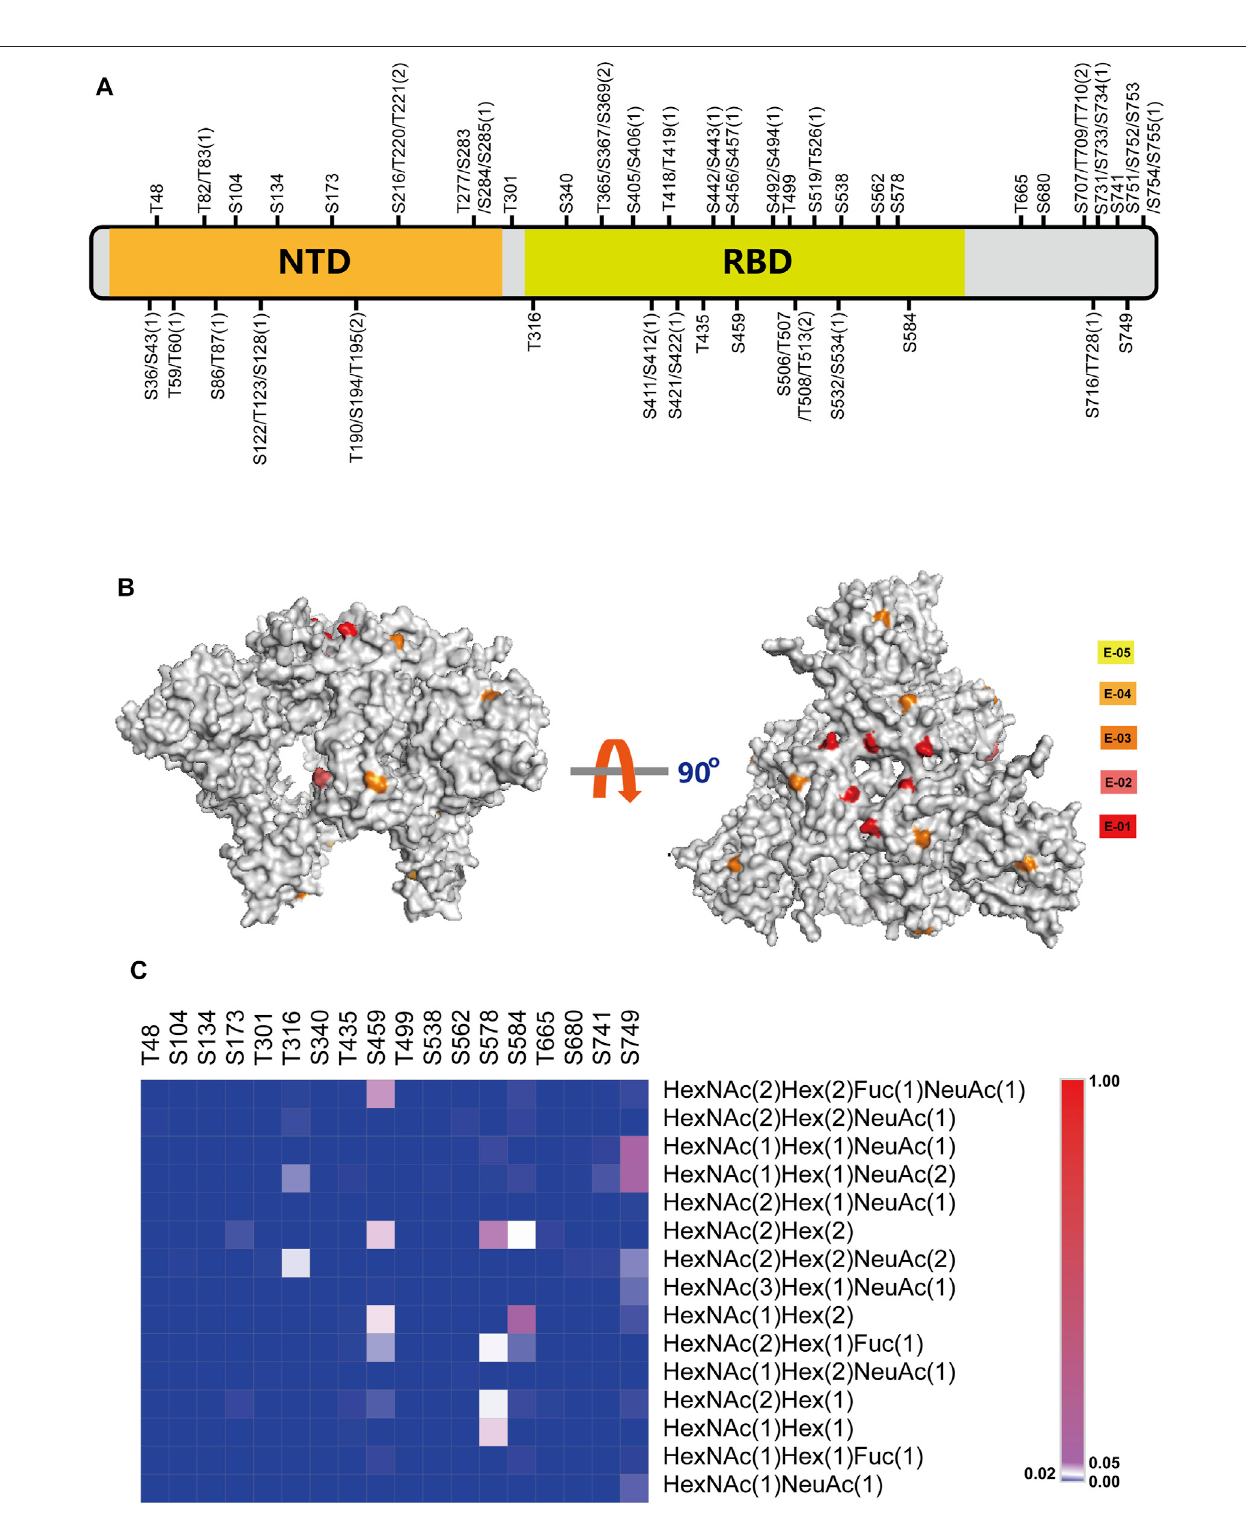
FIGURE5| ComprehensiveO-glycosylationanalysisofHKU1S1protein. (A) SchematicrepresentationofO-glycosylationsites(OGSs)identi fi edonHKU1S1.The ambiguous identi fi ed OGSsare labeled with potential S/T with the possible number ofOGSs in bracket. N-terminal domain (NTD) islabeled in orange, and the receptor- binding domain (RBD) is labeled in lime green. Detailed information about the peptide sequences and glycosylation is shown in Supplementary Table S5 . (B) The normalized O-glycosylation abundance on unambiguous OGSs mapped on HKU1 S1 (PBD code: 5I08). The normalized O-glycosylation abundance was calculated by dividing the O-glycosylation abundance on each O-glycosylation site bythe total O-glycosylation abundance of HKU1 S1. Five orders of magnitudes were selected to label the normalized sialylated O-glycosylation abundance with yellow (E-05), bright orange (E-04), orange (E-03), deep salmon (E-02), and red (E-01), respectively. (C) The distribution of site-speci fi c O-linked glycans on the individual O-glycosylation site.